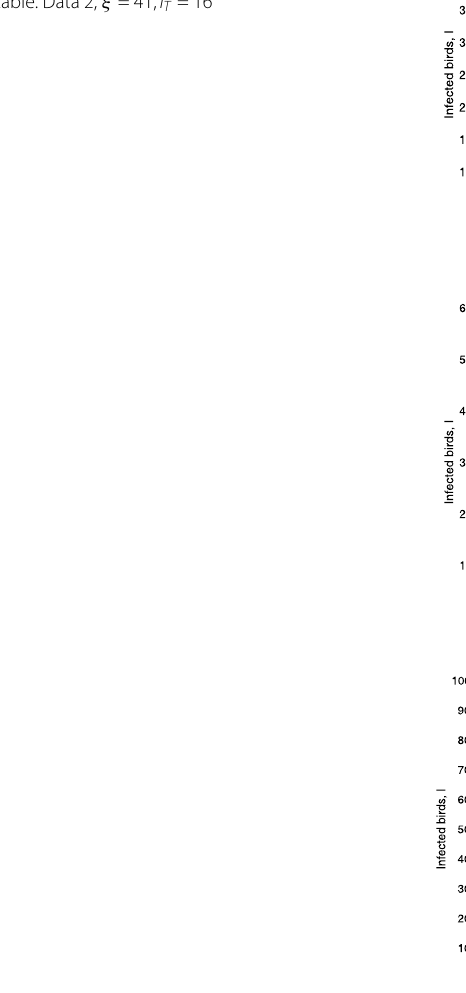
Figure 9 Global dynamics in Case C.1: ( a ) E R 2 is globally asymptotically stable. Data 2, ξ = 1.01, I T = 16; ( b ) E p 2 is globally asymptotically stable. Data 2, ξ = 2, I T = 16; ( c ) E R 1 is globally asymptotically stable. Data 2, ξ = 41, I T =